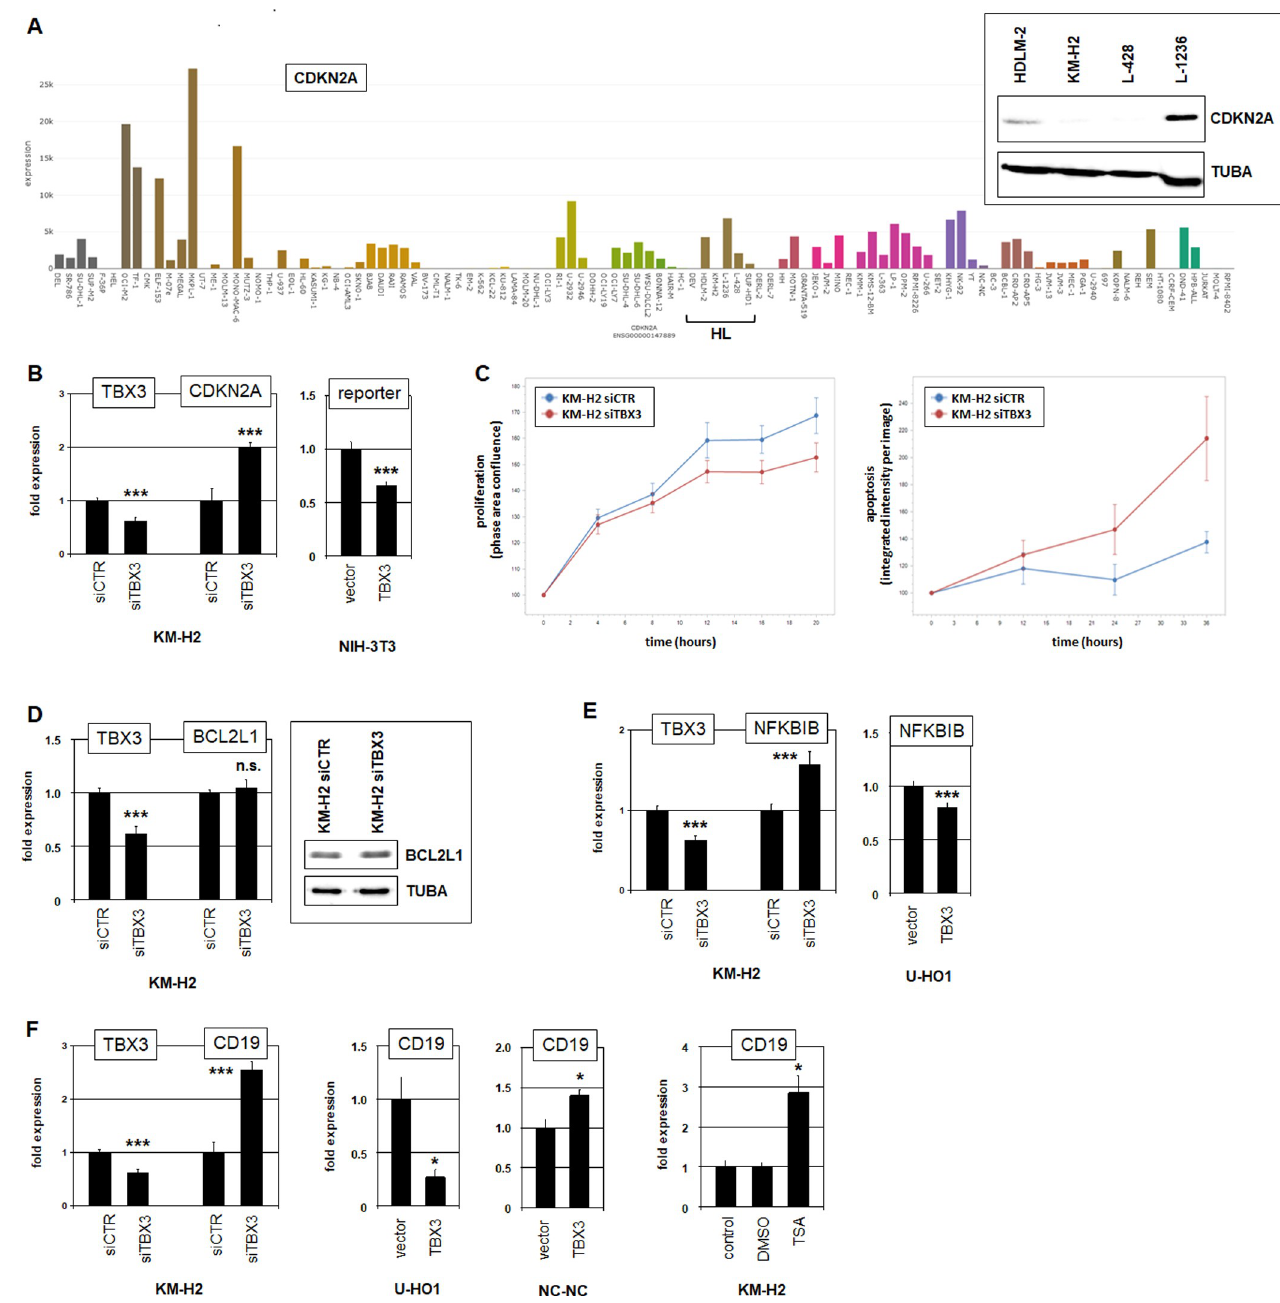
Fig 6. TBX3 represses CDKN2A, NFKBIB and CD19. (A) RNA-seq data show expression levels of CDKN2A in 100 leukemia/lymphoma cell lines using dataset E-MTAB-7721. Transcript levels of CDKN2A are very heterogenious, showing reduced gene activity in HL cell line KM-H2. HL cell lines are indicated. Western blot analysis of CDKN2A (insert) reflects transcript levels, showing elevated expression in L-1236, medium level in HDLM-2, and undetectable protein in KM-H2 and L-428. TUBA served as loading control. (B) RQ-PCR analysis of CDKN2A after siRNA-mediated knockdown of TBX3 (left). Data indicated that TBX3 inhibited CDKN2A expression. Reporter-gene assay in NIH-3T3 cells demonstrated that TBX3 suppressed CDKN2A via its consensus site located at –1293 bp (right). (C) Live-cell-imaging of KM-H2 cells treated for siRNA-mediated knockdown of TBX3 showed that TBX3 promoted proliferation (left, p = 0.01) and inhibited apoptosis (right, p = 0.04). (D) RQ-PCR analysis (left) and Western blot analysis (right) of BCL2L1/BCLXL after siRNA-mediated knockdown of TBX3. Data indicated that TBX3 regulated neither transcription nor splicing of BCL2L1. (E) RQ-PCR analysis of NFKBIB after siRNA-mediated knockdown of TBX3 in KM-H2 (left), and after forced expression of TBX3 in U-HO1 (right). Data indicated that TBX3 inhibited the expression of NFkB- signaling inhibitor NFKBIB. (F) RQ-PCR analysis of CD19 after siRNA-mediated knockdown of TBX3 in KM-H2 (left), and after forced expression of TBX3 in U-HO1 and NC-NC (middle). RQ-PCR analyses of CD19 after treatment with histone deacetylase inhibitor TSA in KM-H2 (right). The data indicated that TBX3 inhibited the transcription of B-cell differentiation marker CD19 by recruitment of histone deacetylases.